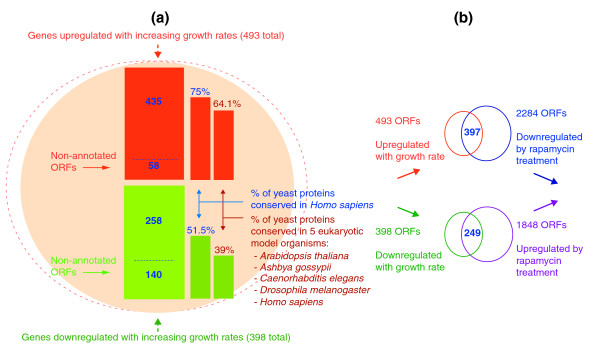
Cell-growth regulation of gene expression at the transcriptional level. (a) Groups of genes significantly upregulated (main red block) and downregulated (main green block) with growth rate irrespective of the nutrient-limiting condition, and their conservation in eukaryotes. The smaller blocks to the right represent the percentages of conserved orthologous proteins in Homo sapiens alone and in five model eukaryotic organisms [52]. The number of non-annotated open reading frames (ORFs) in up- and downregulated lists (that is, ORFs/genes of unknown function Affymetrix annotation 12 July 2006) is included. (b) Target-of-rapamycin (TOR) regulation at the transcriptional level. Genes upregulated and downregulated with growth rate are indicated by red and green circles, respectively. Groups of genes whose transcription is significantly downregulated by rapamycin treatment are indicated by the blue circle; those upregulated by the purple circle. Overlapping areas indicate groups of specific growth-related genes whose expression is significantly affected by rapamycin at the transcriptional level.